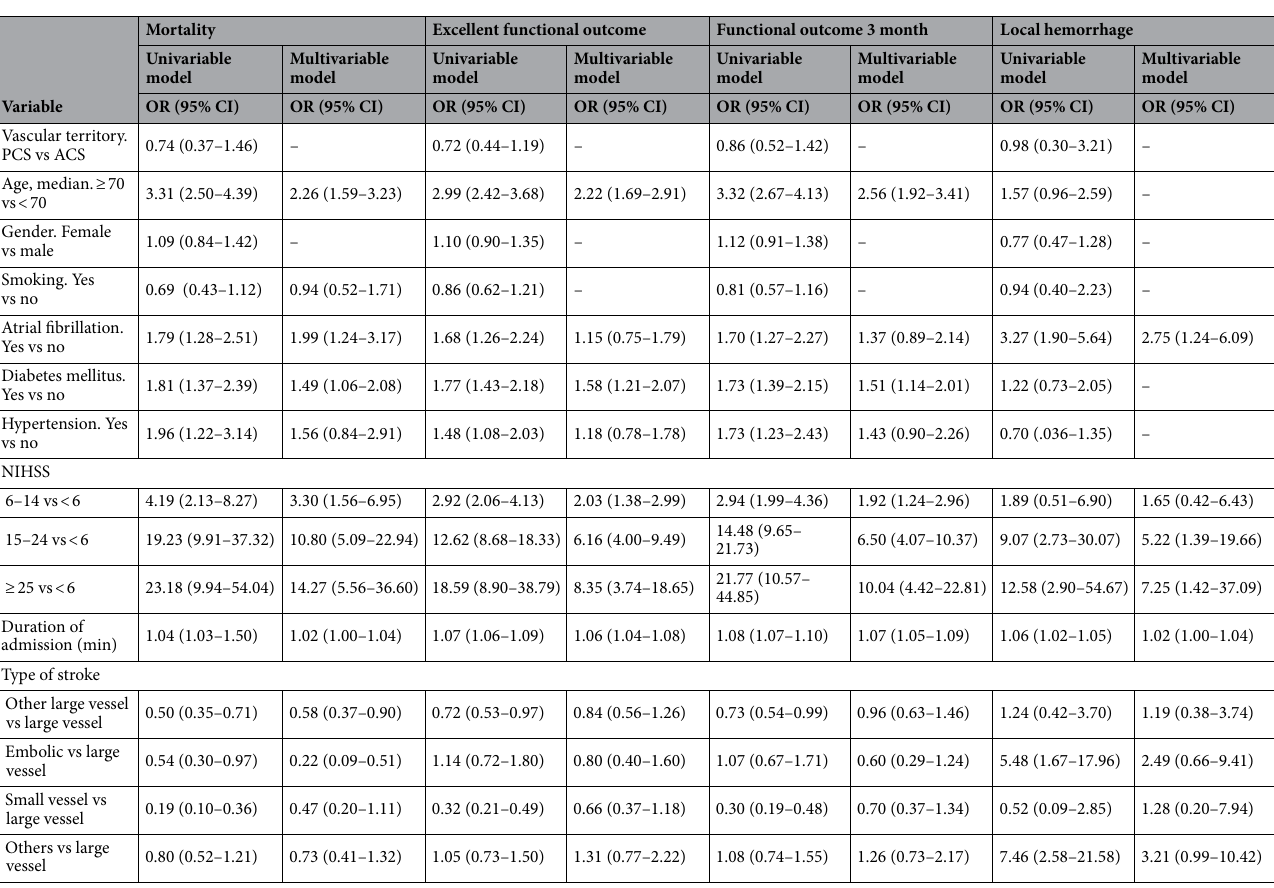
Table 3. Univariable and multivariable odds ratio (OR) of outcome of IVT ischemic stroke cases according to risk